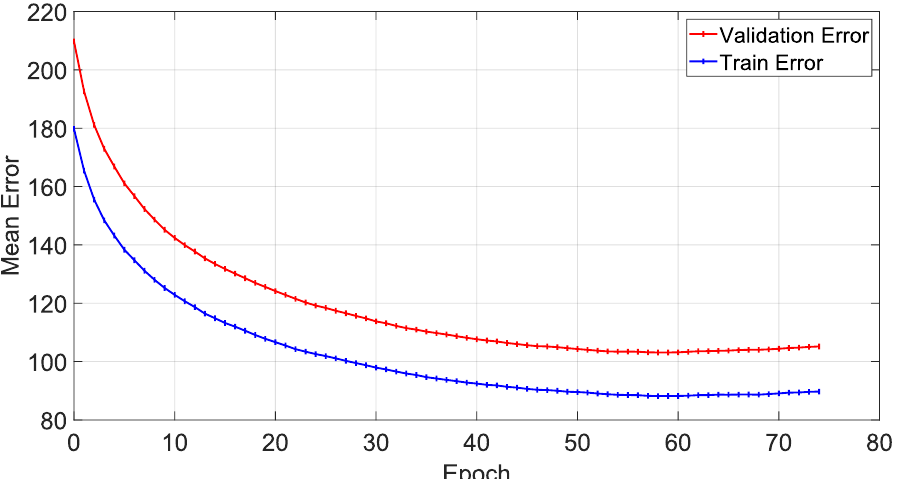
Figure 10. Mean error of training and validation data over epochs.